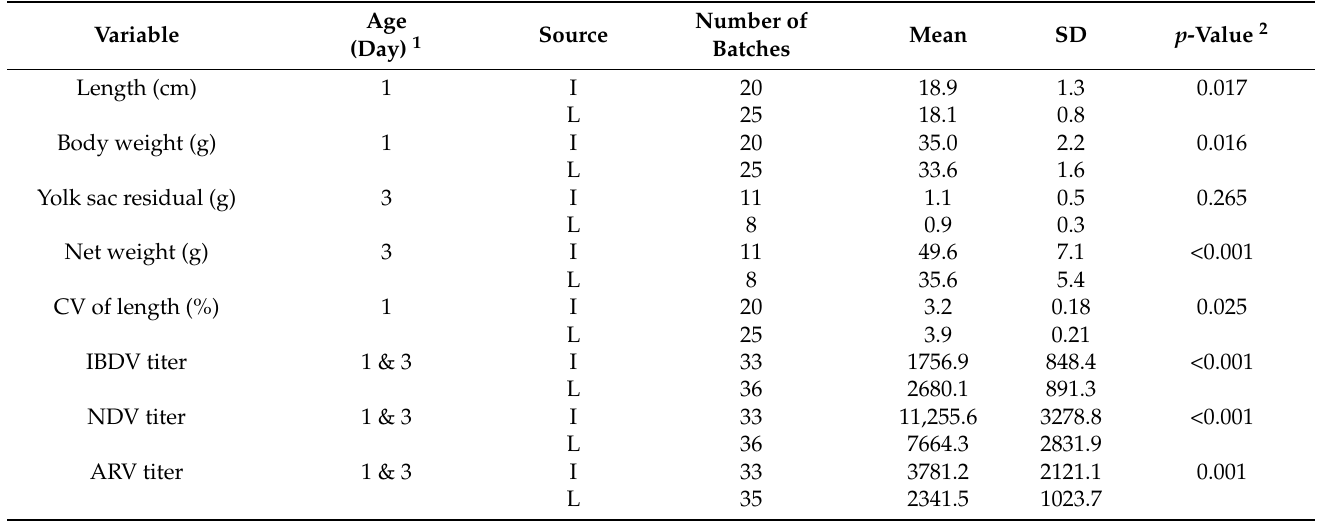
Figure 2. Distribution of the means of ELISA antibody titers for IBDV, NDV, and ARV at the batch level by source (imported in gray and local in white). Each box represents the interquartile range, including the median line. Whiskers represent the lowest and highest adjacent values (the most extreme values within 1.5 interquartile range of the nearer quartile). “*” = multiplied by. Table 2. Summary statistics and comparison of the batch-level quality parameters by source (imported = I vs. local = L) for the 70 batches of day-old chicks in the